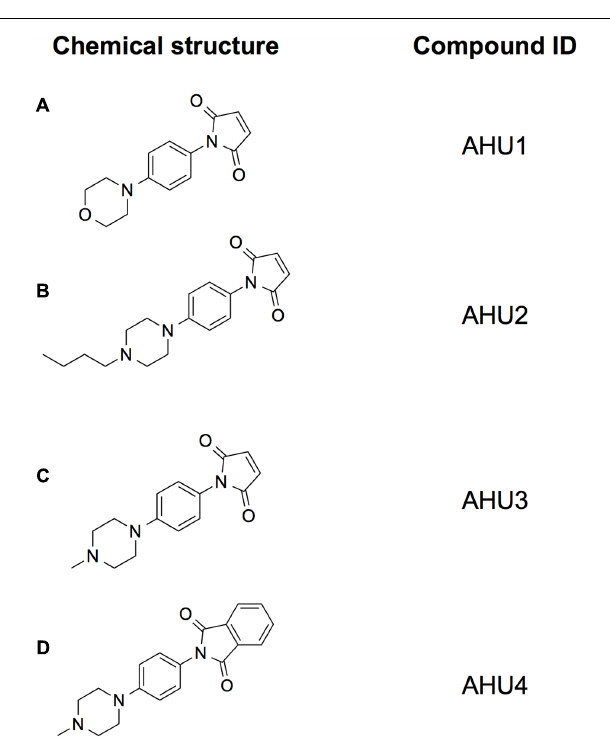
FIGURE 2 | Structures of the compounds used in this study. Chemical structures of the hit compound AHU1 (A) , and its derivatives AHU2 (B) , AHU3 (C) , and AHU4 (D) . The maleimide moiety was determined to be essential for the molecule to be biologically active since its loss in the derivative AHU4 led to